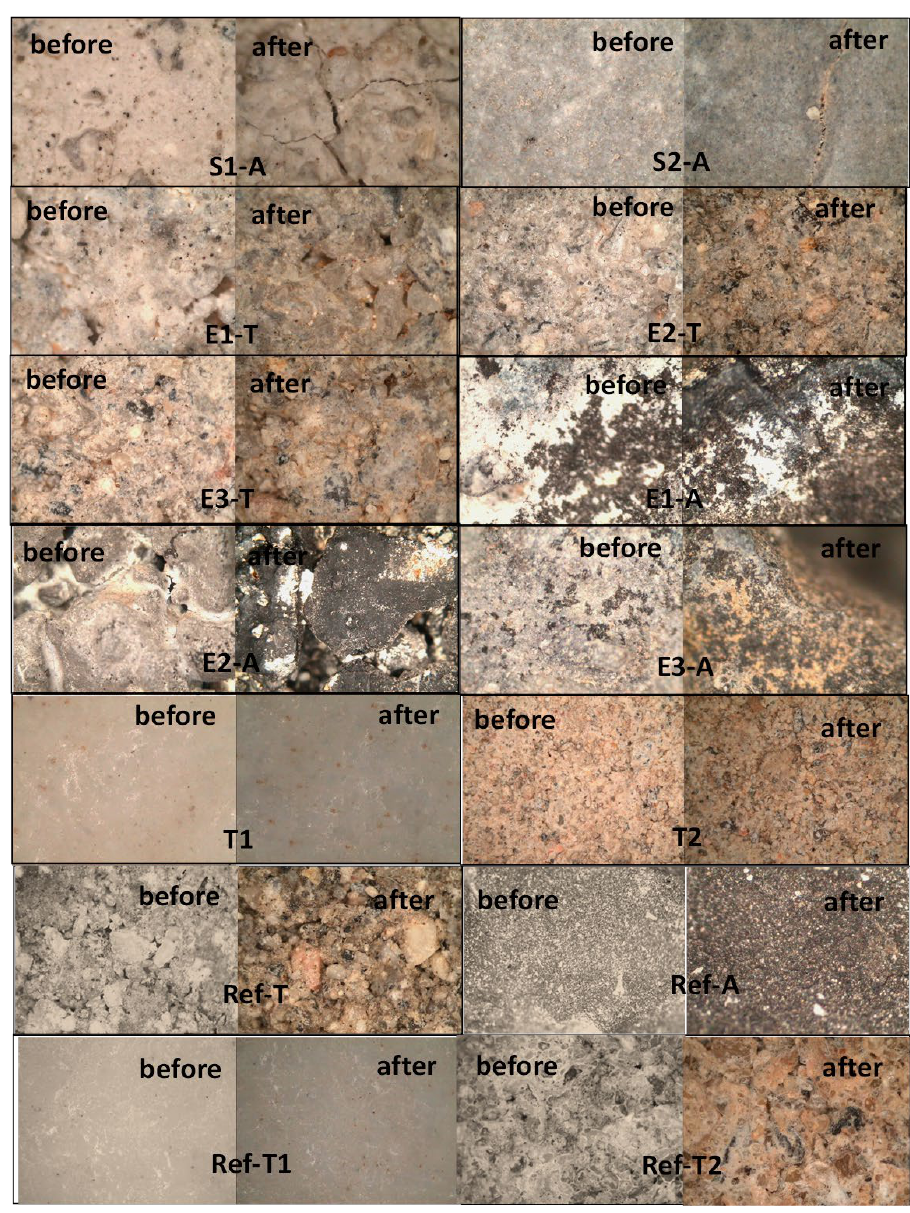
Figure 7. Optical micrographs (×3 magnifications) of the photocatalytic samples before and after the freeze-thaw trials.